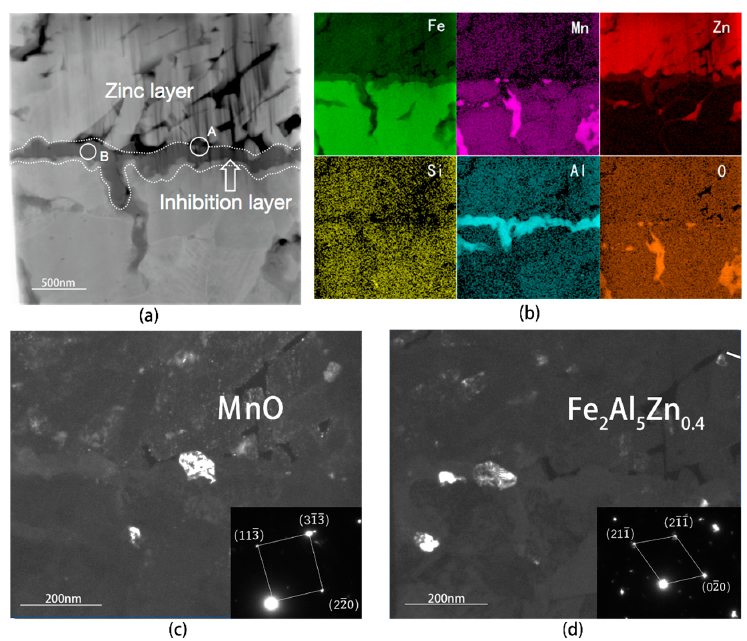
Figure 11. ( a ) TEM analysis of the Zn coating/Fe substrate interface of the galvanized sample1#. ( b ) cross-sectional elemental maps of the area. ( c ) Dark filed image and diffraction pattern of the oxide particle corresponding to zone A in ( a ). ( d ) Dark filed image and diffraction pattern of the inhibition layer corresponding to zone B in ( a ).